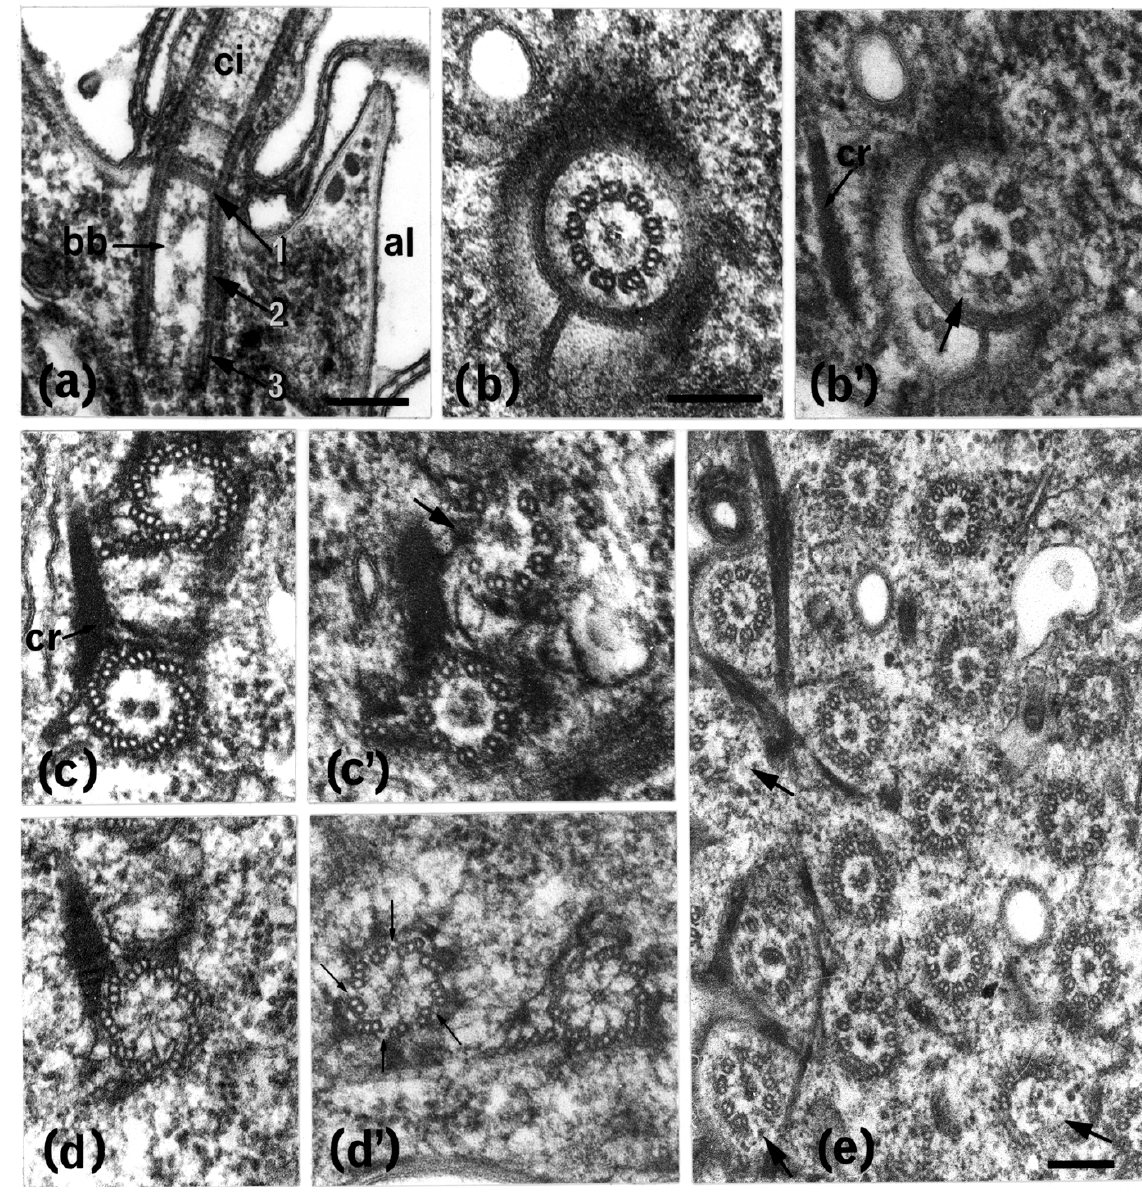
Figure 3 Cytological abnormalities induced by inactivation of the δ PT1 gene: ultrastructural level. (a) Longitudinal section through a basal body (bb) and its cilium (ci) anchored in the surface between subpellicular alveoli (al). (b),(b'),(c),(c') and (d), (d') compare cross-sections at levels 1, 2 and 3, illustrated in (a), from control (b,c,d) and inactivated cells (b', c', d'). All sections are similarly oriented with respect to basal body and cell polarities and shown as seen from the cell center. Ciliary rootlets (cr) run upwards and to the left of the observer; newly formed basal bodies position anterior to the parent. (b), (b'): near the terminal plate (level 1), the C-tubules, visible in b are absent in b'. (c), (c'): level 2 section through mother and daughter basal bodies; in c', the mother organelle (posterior) shows a ring of 8 doublets and 1 triplet; the daughter basal body shows a more defective structure with one, possibly two singlets; the basis of the ciliary rootlet appears narrower and less dense in c'. (d), (d'): cross- section through level 3, showing the cartwheel; in (d'),both basal bodies show doublets and triplets (small arrows). (e): level 2 section through a field ("anarchic field" destined to generate a new oral apparatus at their next division) of basal bodies near the oral apparatus of a transformed cell showing rings of 9 doublets: note the incomplete rings (arrows), with empty triplet sites, as in (b') and (c'). Bars: 0.2 μ M; same magnification in (b), (b'), (c), (c'), (d) and